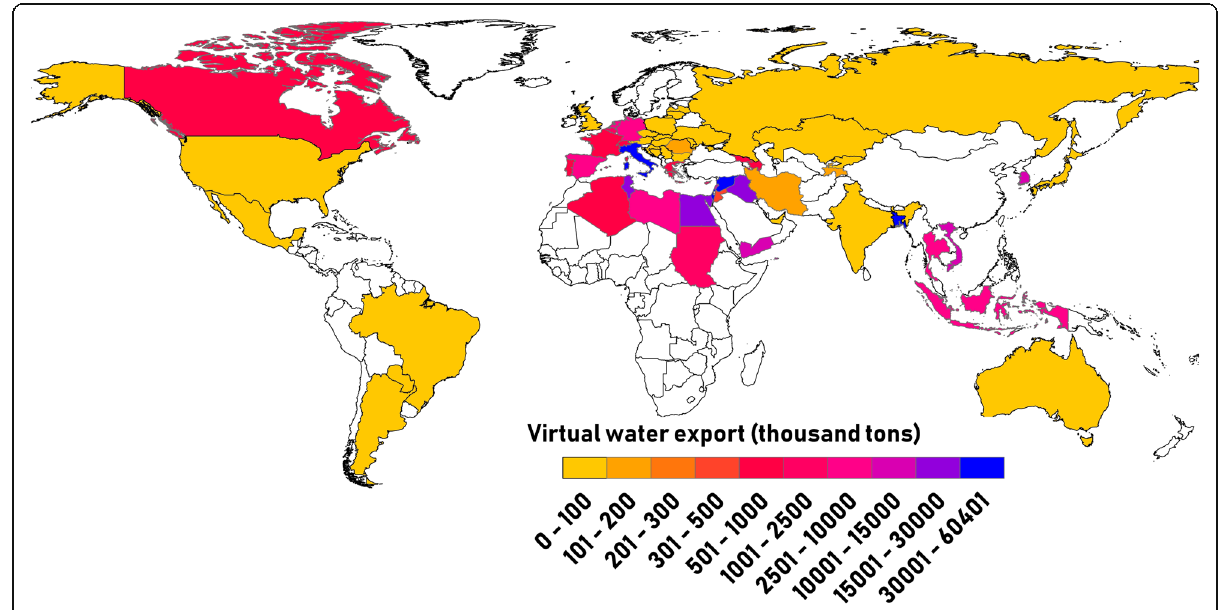
Fig. 9 Illustration of Turkey ’ s virtual water exports